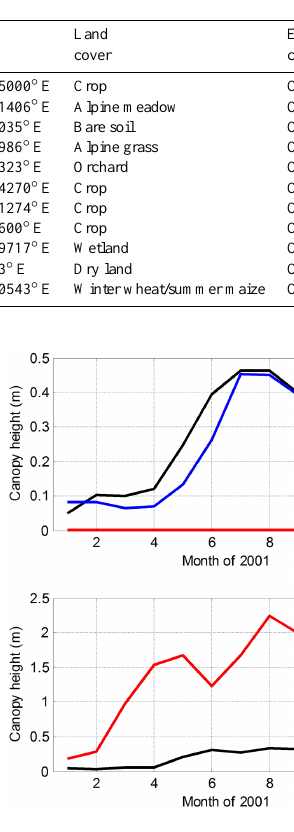
Table 2. Flux tower sites supplying measurement data for product validation.